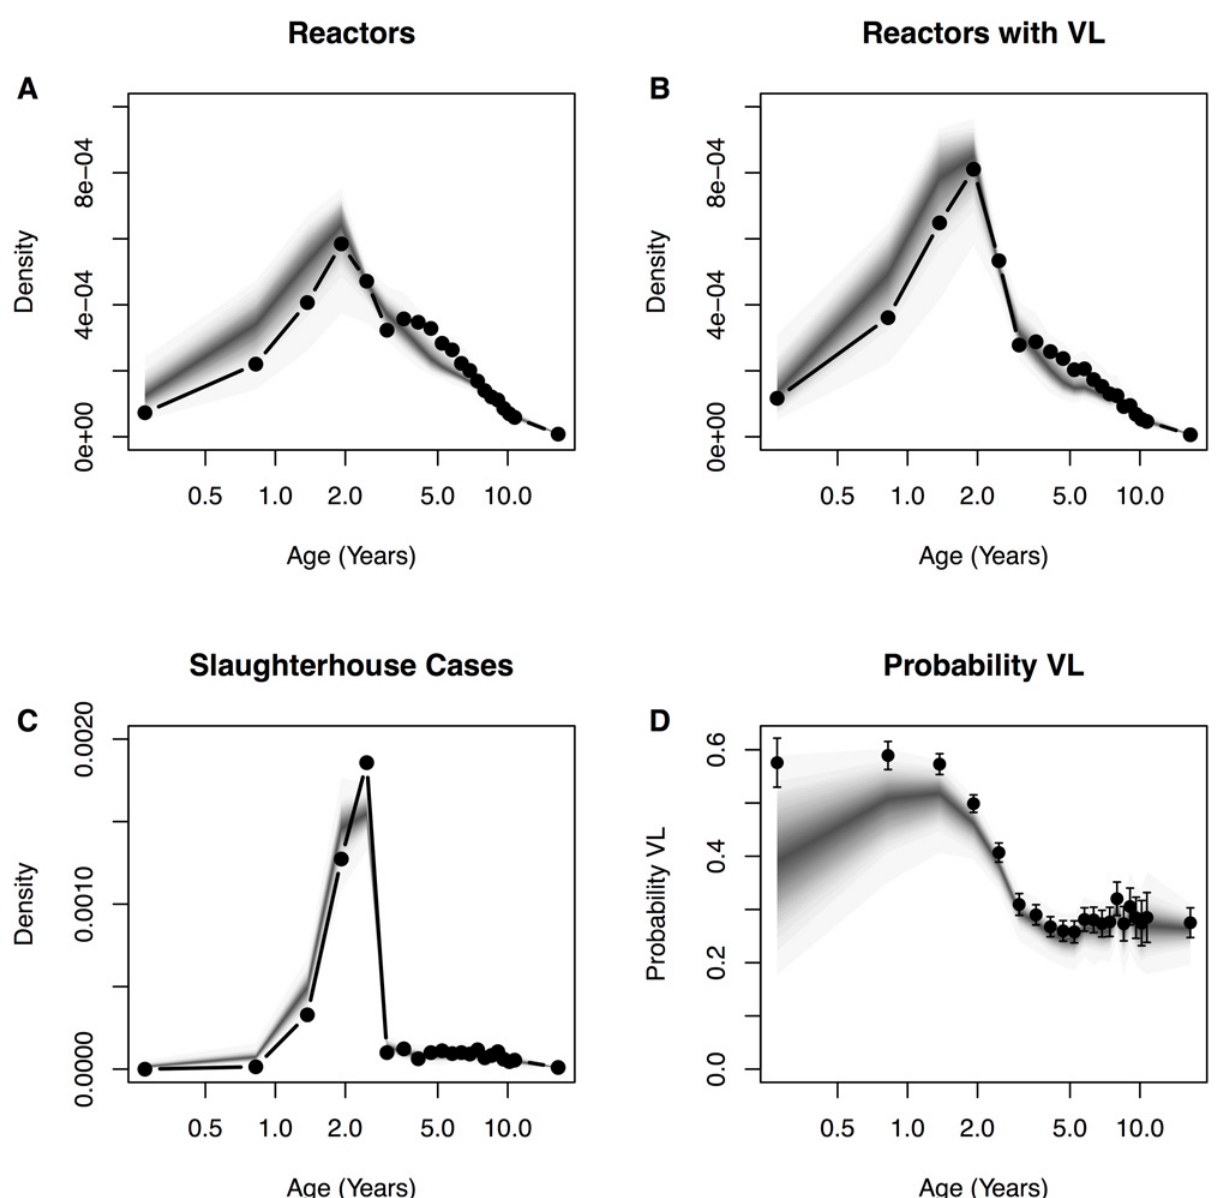
Fig 3. SORI model fit to age-distributions of reactors. SORI model predictive distributions for the age of reactors ( A ). Age of “ confirmed ” reactors with evidence of visible lesions ( B ). Slaughterhouse cases ( C ) and the proportion of animals with visible lesions stratified by age ( D ). Solid points and lines indicate empirical target distributions, model predictive distributions are once again overplotted as shaded density strips where the intensity of color is proportional to the probability density at that point [34].